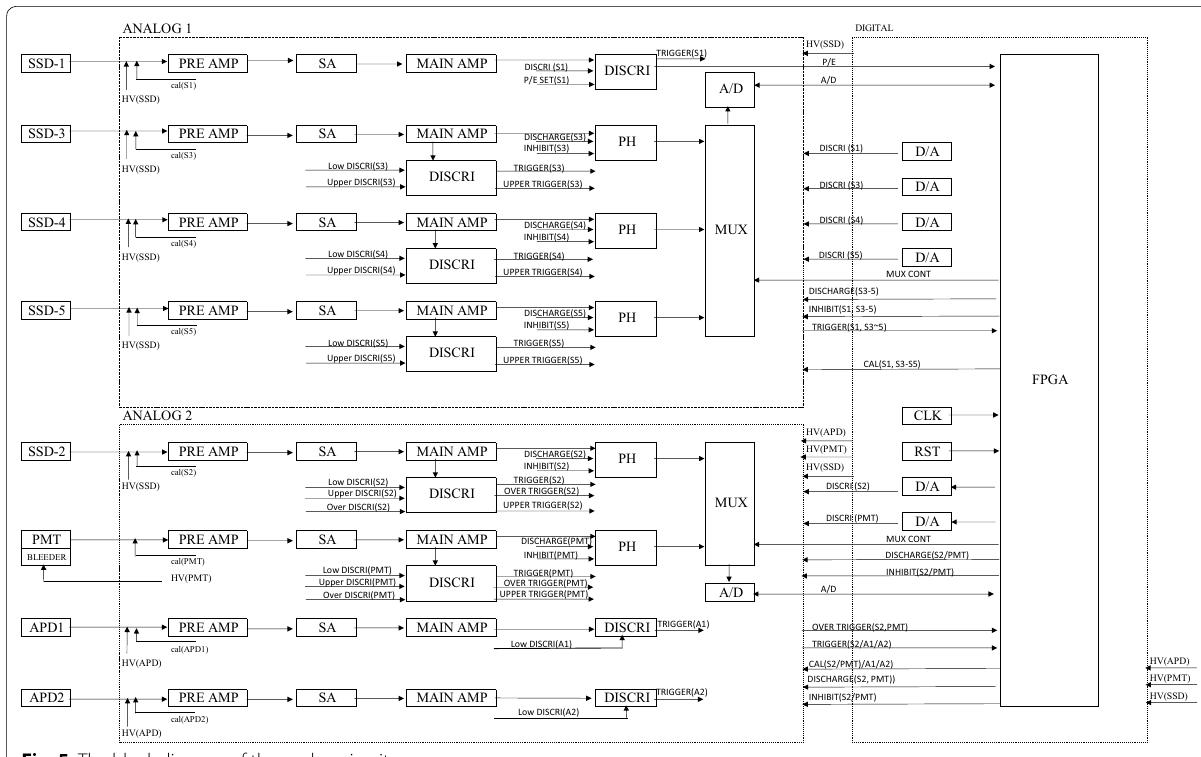
Fig. 5 The block diagram of the analog